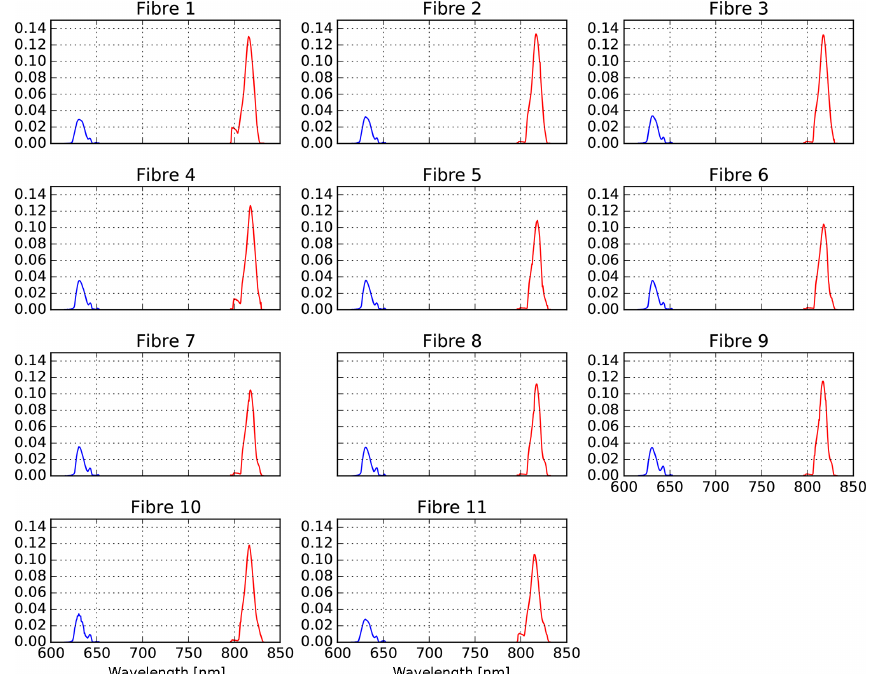
Figure 27. Overview of the normalized and integrated contributions to straylight (SL) from both the red long wavelength side (red line) and the blue short wavelength side (blue line) for a flat spectrum. The figures for all fibres show that the contribution to the total straylight on the detector is dominated by signal originating from the long wavelength side and that there is no strong across-track